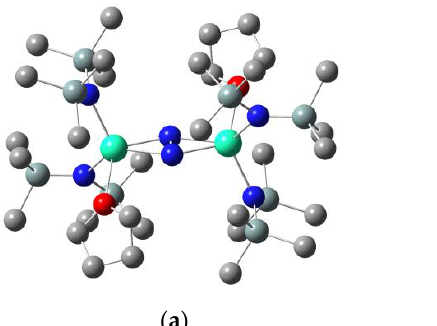
single fragment compound for this system in CASSCF calculations. Ln, dark cyan; La, turquoise; C, gray; N, blue; O, red; ( b ) Model structure of